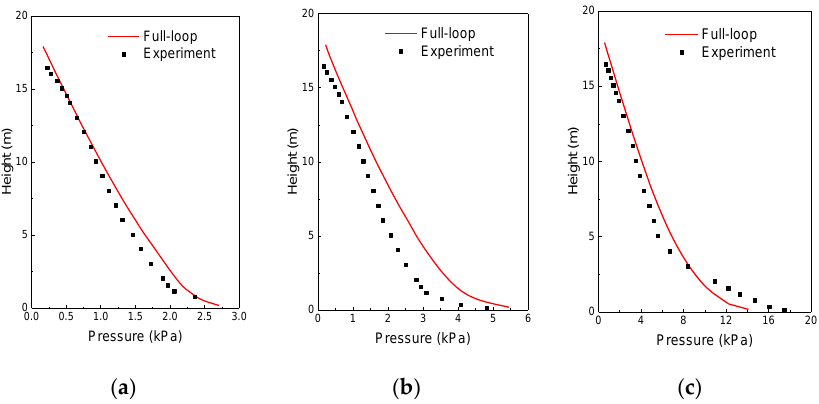
Figure 3. Comparison of time-averaged axial pressure profiles of the riser in simulation and experiment. ( a ) U g = 7 m s − 1 , Gs = 50 kg m − 2 s − 1 ; ( b ) U g = 7 m s − 1 , Gs = 100 kg m − 2 s − 1 ; ( c ) U g = 7 m s − 1 , Gs = 300 kg m − 2 s − 1 .